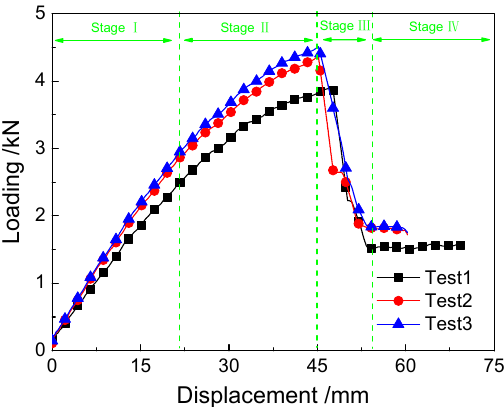
Figure 10. Load-displacement curves of the experiments.